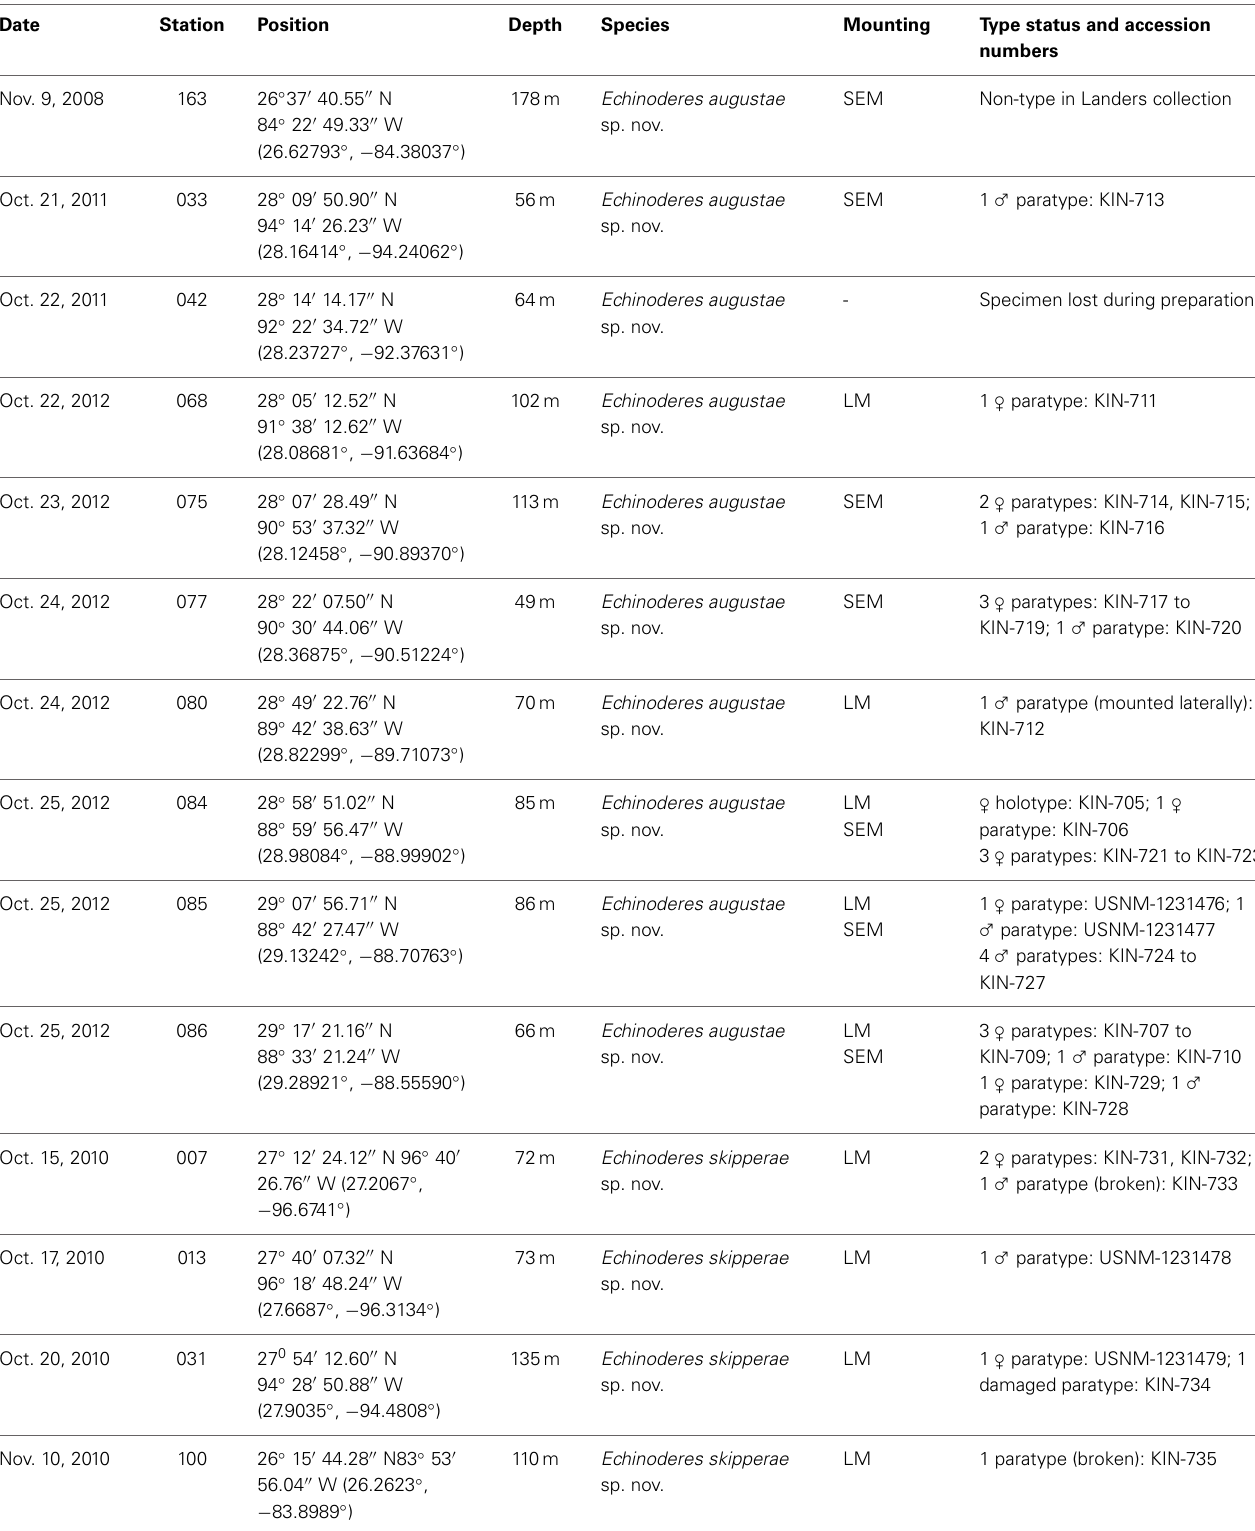
Table 1 | Summary of data on stations, species identities, and accession